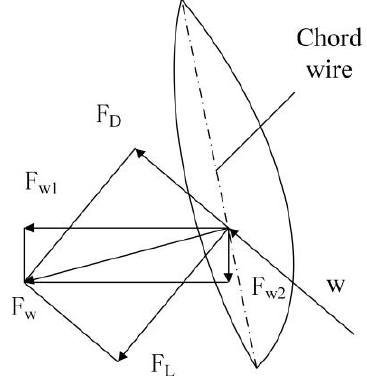
Figure 3. Force diagram of blade section.